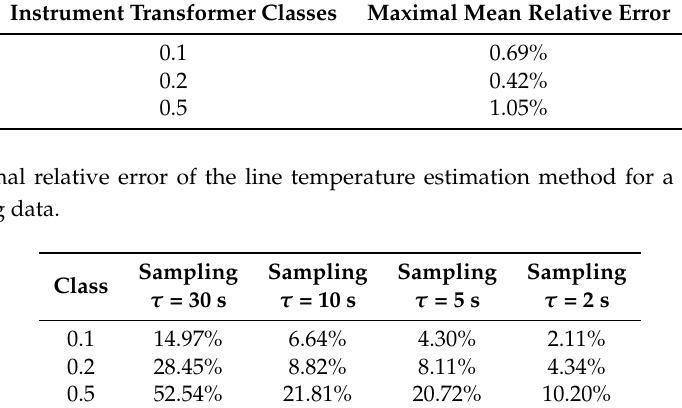
Table 2. Mean relative error of the line temperature estimation method resulting from various classes of the applied measuring apparatus and obtained for a complete set of noise-containing measurement data.